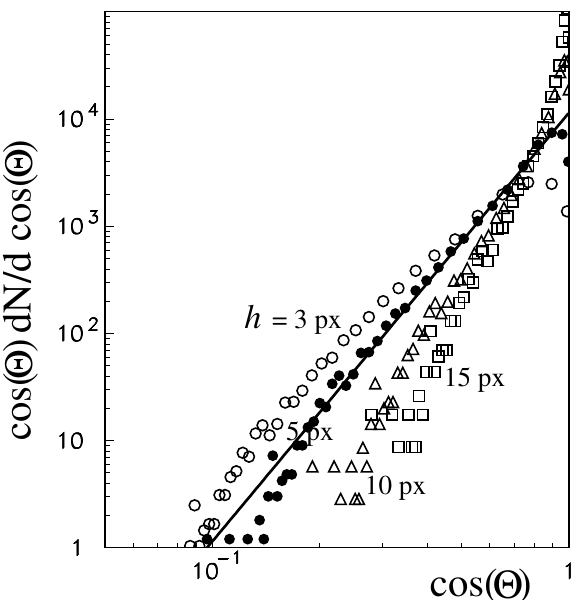
Figure 6. Observed distributions of cos ( Θ ) calculated with different assumptions of the thickness of the camera matrix sensitive layer: empty circles for h = 3 px thickness, solid circles—5 px, triangles— 10 px, and squares—15 px layer thickness. The solid line represents the expectations for the cos 2 ( Θ ) dependence and our best fit h = 5.7 px (details in the text). The right end of the abscissa corresponds to the vertical muons, while the left one to almost horizontal (89 ◦ )